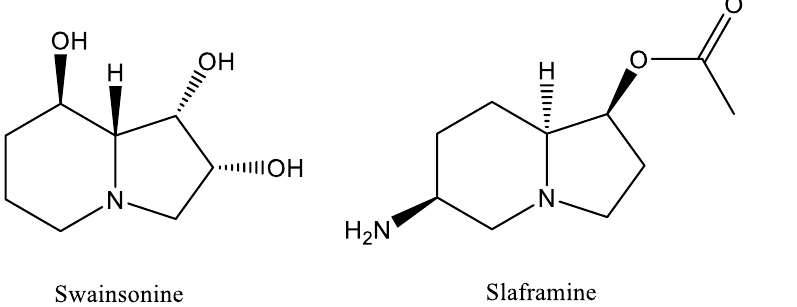
Figure 1. Chemical structure of swainsonine and slaframine, two mycotoxins produced by Slafractonia leguminicola .